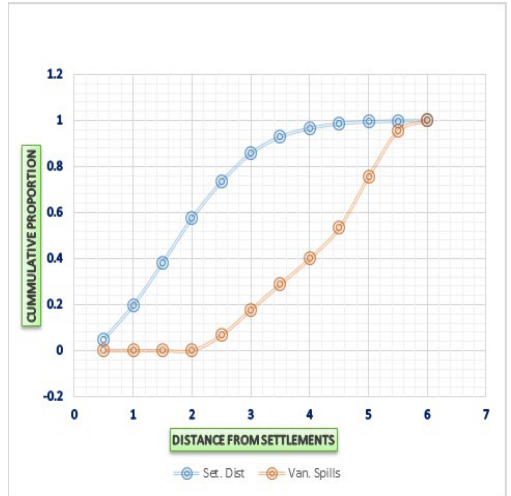
Figure 10. Proximity of settlements to the vandalization points